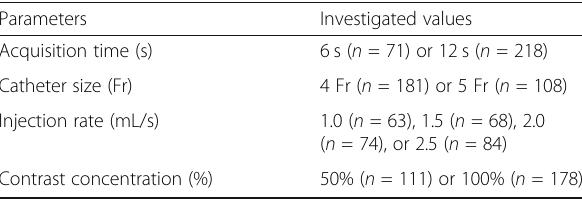
Table 1 The acquisition and injection parameters that were changed to investigate their impact on the sideband ratio